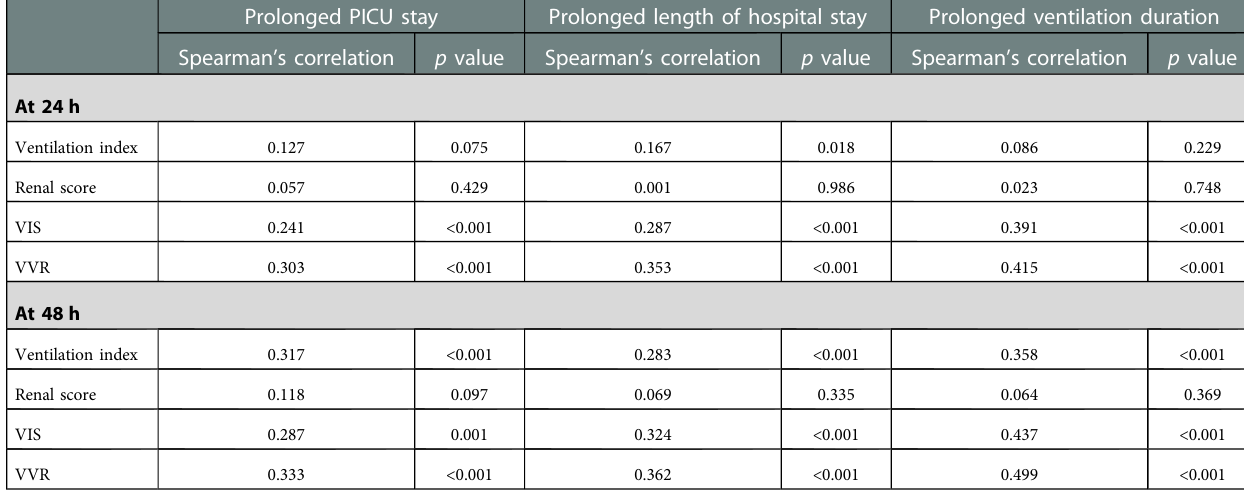
TABLE 5 Spearman ’ s correlation of different scores for the outcomes of interest (prolonged PICU stay, prolonged length of hospital stay, and prolonged ventilation duration).